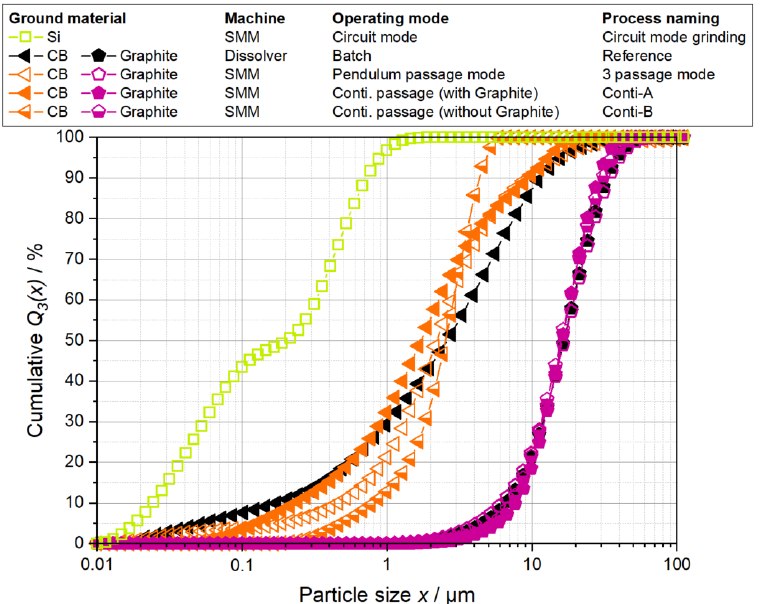
Figure 14. Particle size sum distributions Q 3 ( x ) of the particulate components of the battery slurry: silicon (exemplary) as well as carbon black and graphite, which were processed using four different processes.